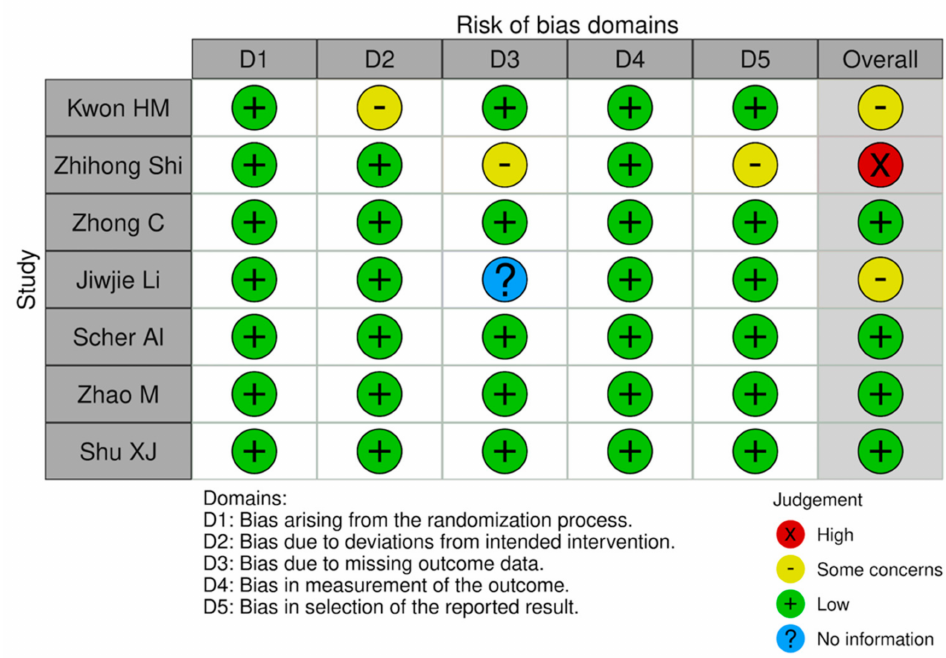
Figure 4. Risk of bias plot of RCTs included in this SR